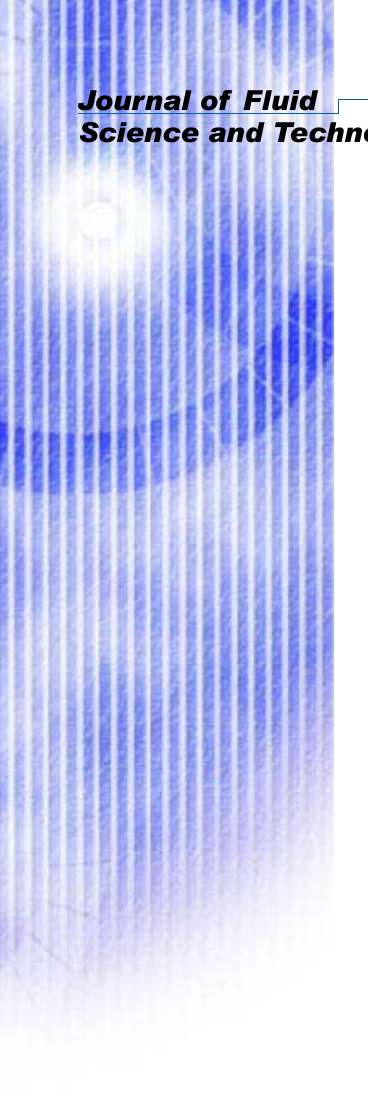
Fig. 5 Electrode layout